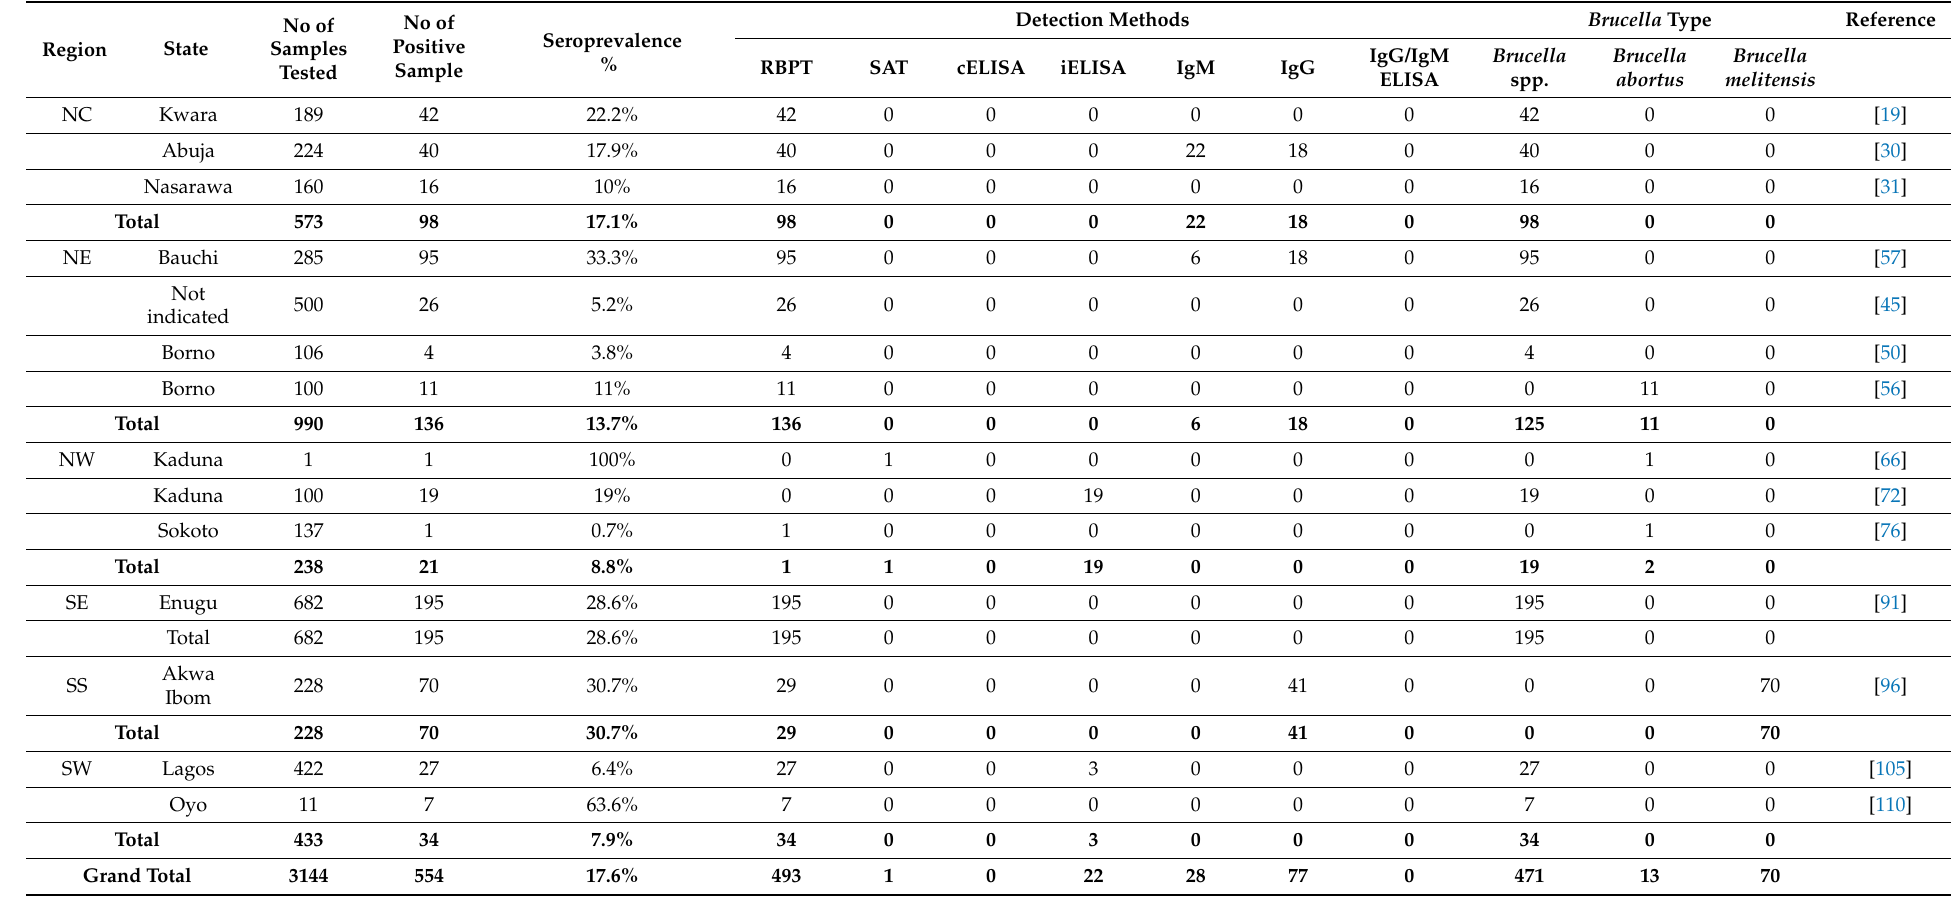
Table 1. Seroprevalence of reported human brucellosis in Nigeria